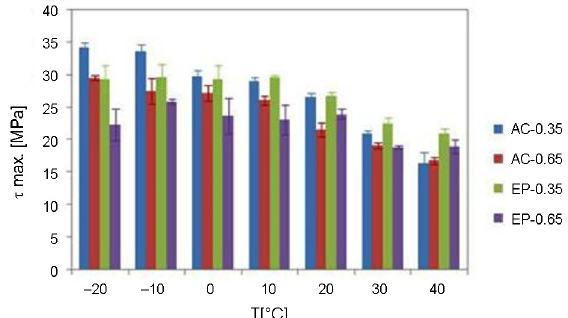
Fig. 2. Test equipment: left: the climate chamber close to the testing machine; right: the laser thermometer used for measuring the temperature at the surface of the specimen